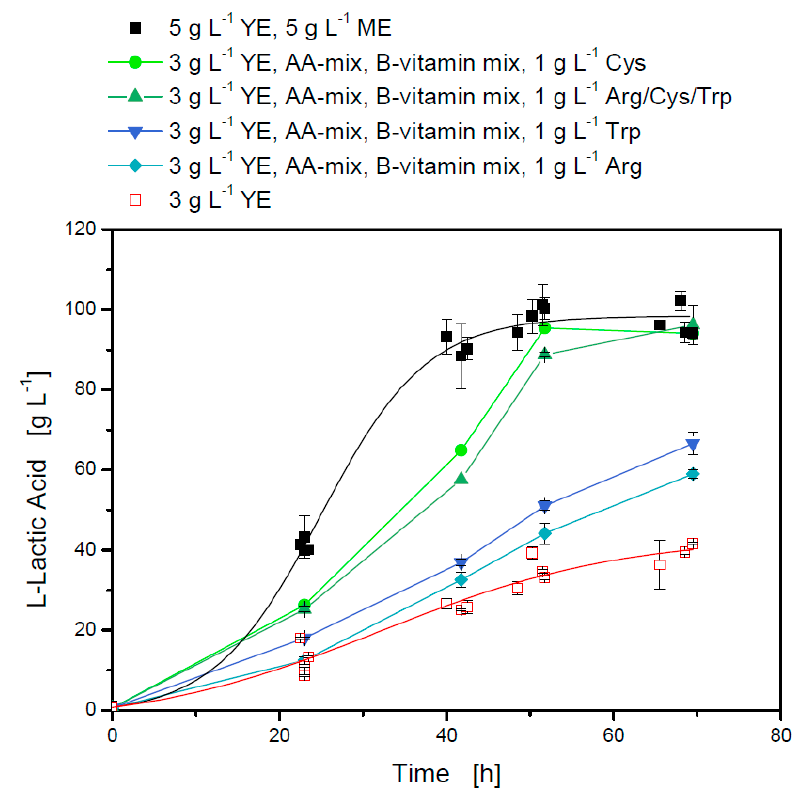
Figure 2. Influence of different medium composition on L -lactate production with L. casei in 24-well plates at 37 °C and 400 rpm: black, closed squares modified MRS medium with 5 g·L − 1 yeast extract (YE) and 5 g·L − 1 meat extract (ME); red, opened squares limited MRS medium with 3 g·L − 1 yeast extract.